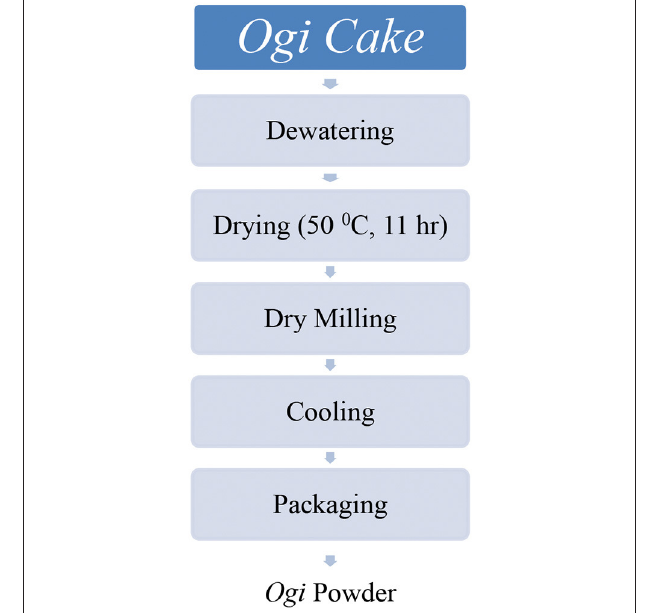
FIGURE 2 | Flow chart for ogi powder production (53,